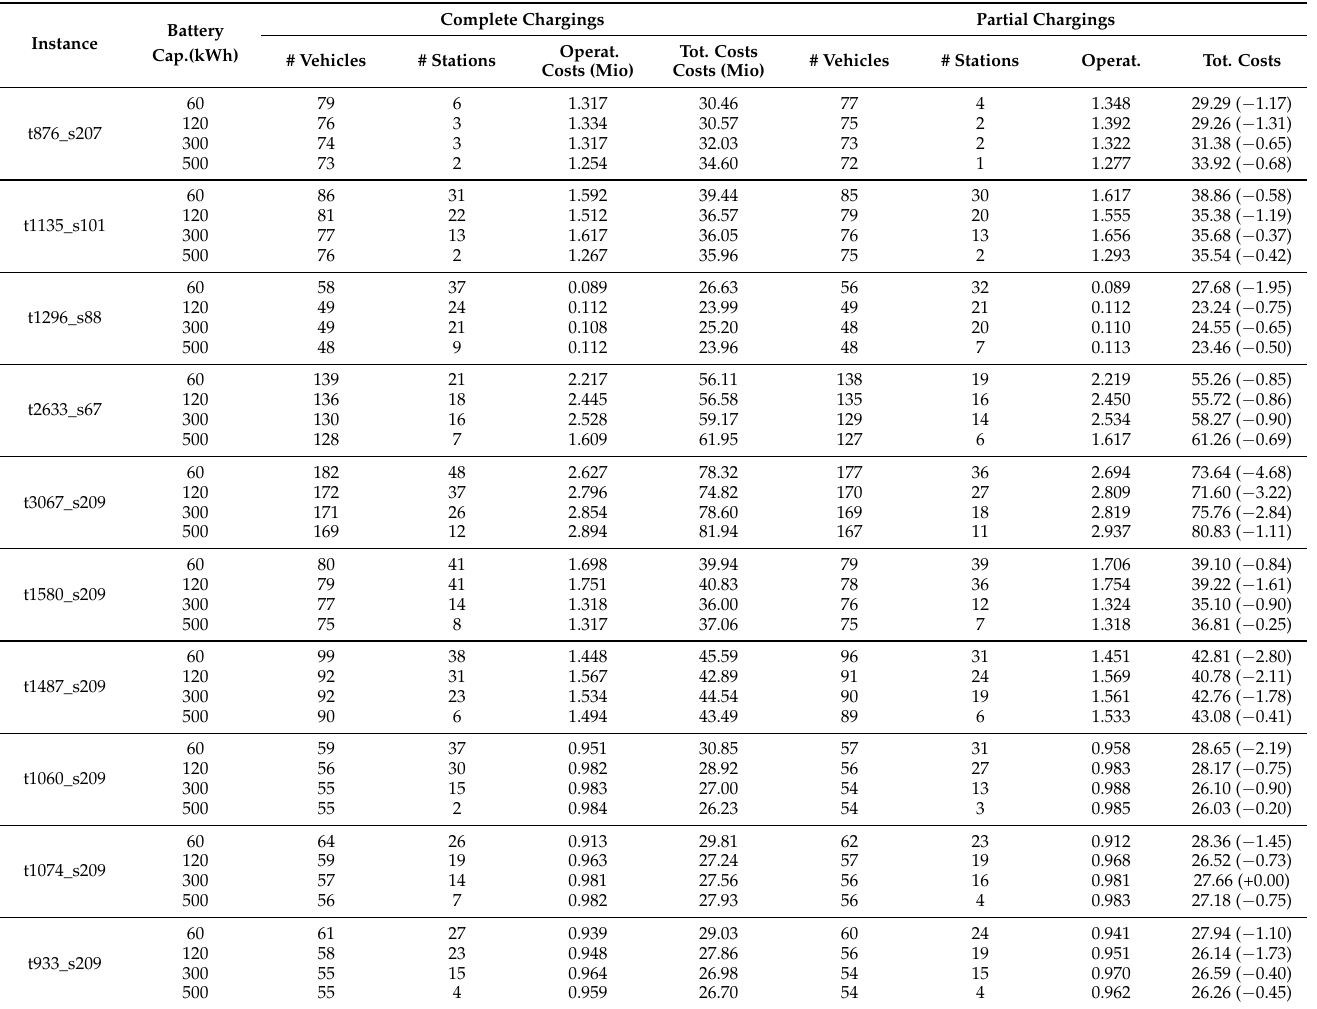
Table 5. Results of Algorithm 3 containing vehicle schedules for electric buses and charging infras- tructure after 100.000 iterations considering complete and partial charging